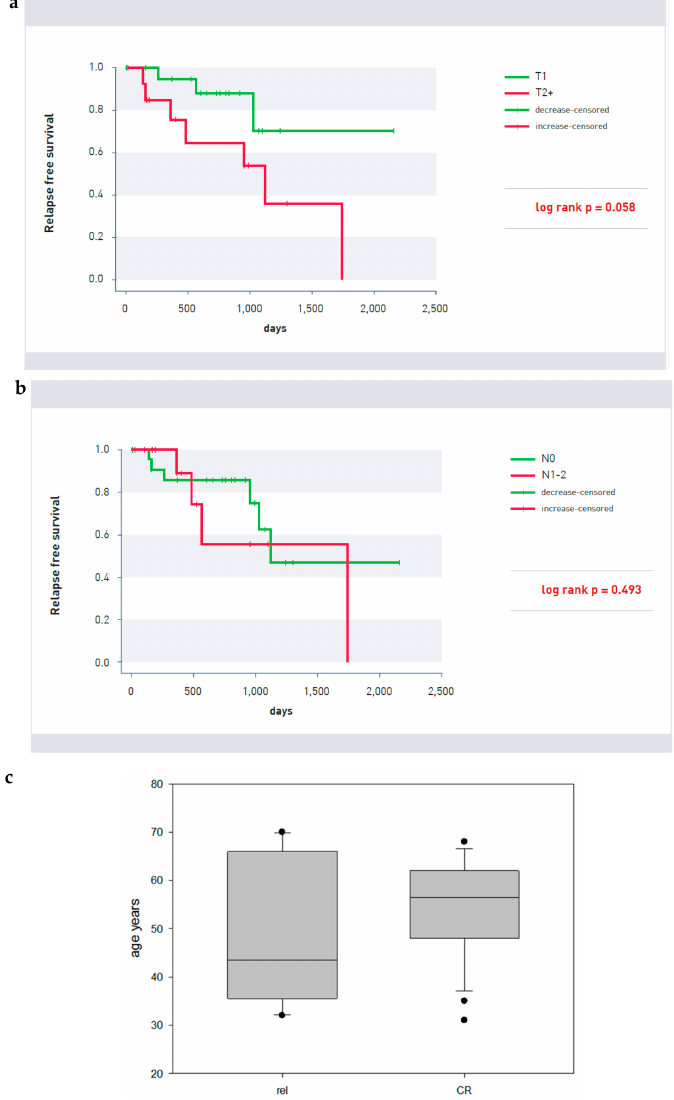
Figure 3. ( a ) Kaplan-Meier survival curve of patients with T2 as well as larger (red line) T1 size tumors (green line) ( p = 0.058). ( b ) Kaplan-Meier survival curve of patients with (red line) and without lymph node involvement (green line) ( p = 0.493). ( c ) Age distribution of patients with (R) and without relapse (CR) (Mann-Whitney U test p = 0.512).